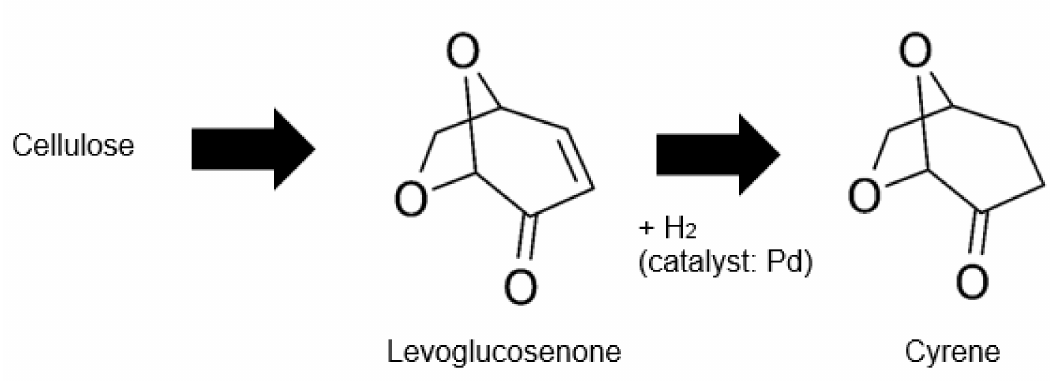
Figure 4. Synthesis of Cyrene, a derivative of